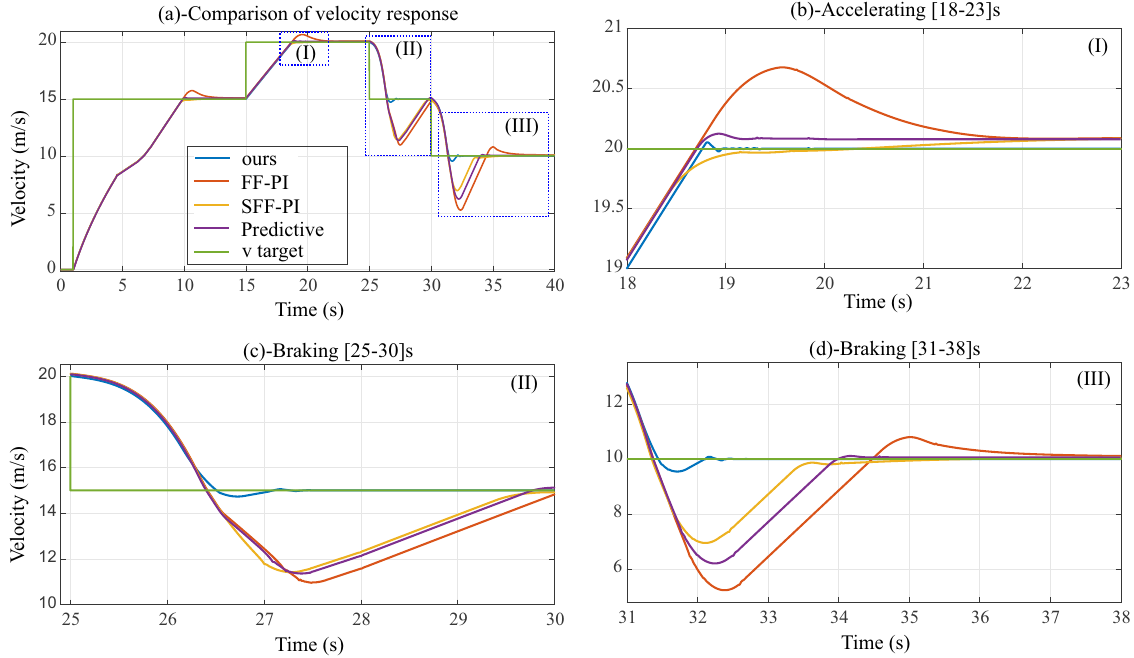
Figure 14. ( a ) the comparison of feedforward PI (FF-PI) controller, SFF-PI controller, predictive controller, and our approach; ( b ) the accelerating results in 18 → 23 s; ( c ) the braking result in 25 → 30 s; ( d ) the braking result in 31 → 38 s.